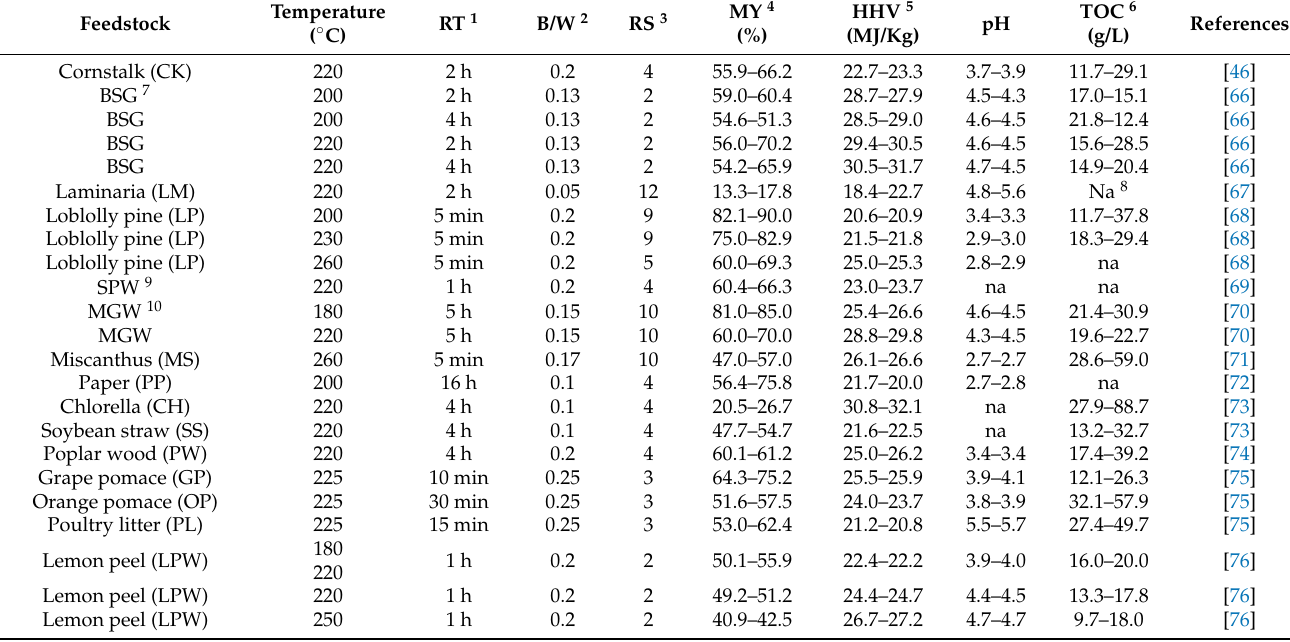
Table 1. Effect of process water recirculation on mass yield (MY) and HHV of hydrochars produced from different residual biomasses, and on pH and total organic carbon (TOC) of HTC liquid phase. For MY and HHV, reference value of HTC step with deionized water and maximum value during recirculation steps are reported. For pH and TOC, reference value of HTC step with deionized water and value of last recirculation step are